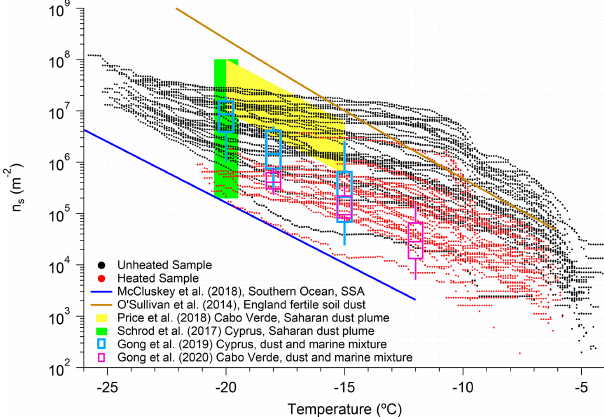
Figure 4. Ice active surface site density ( n s ) of particles larger than 500nm in diameter as a function of temperature for unheated and heated samples in black and red, respectively. Parameterizations from literature of n s for marine aerosol from the Southern Ocean (SSA) and for English fertile soil dust are shown as blue and brown lines, respectively. Ranges of n s for the Saharan dust plumes are shown as green and yellow areas. Ranges of n s for ground-based data in marine regions influenced by Saharan dust are shown as blue and magenta box-plots. Respective literature is cited in the leg- end and in the main text. Data for Schrod et al. (2017), Gong et al. (2019), and Gong et al. (2020) are related to particle surface area > 500nm. Data for Price et al. (2018), O’Sullivan et al. (2018), and McCluskey et al. (2018a) are related to particle surface area >